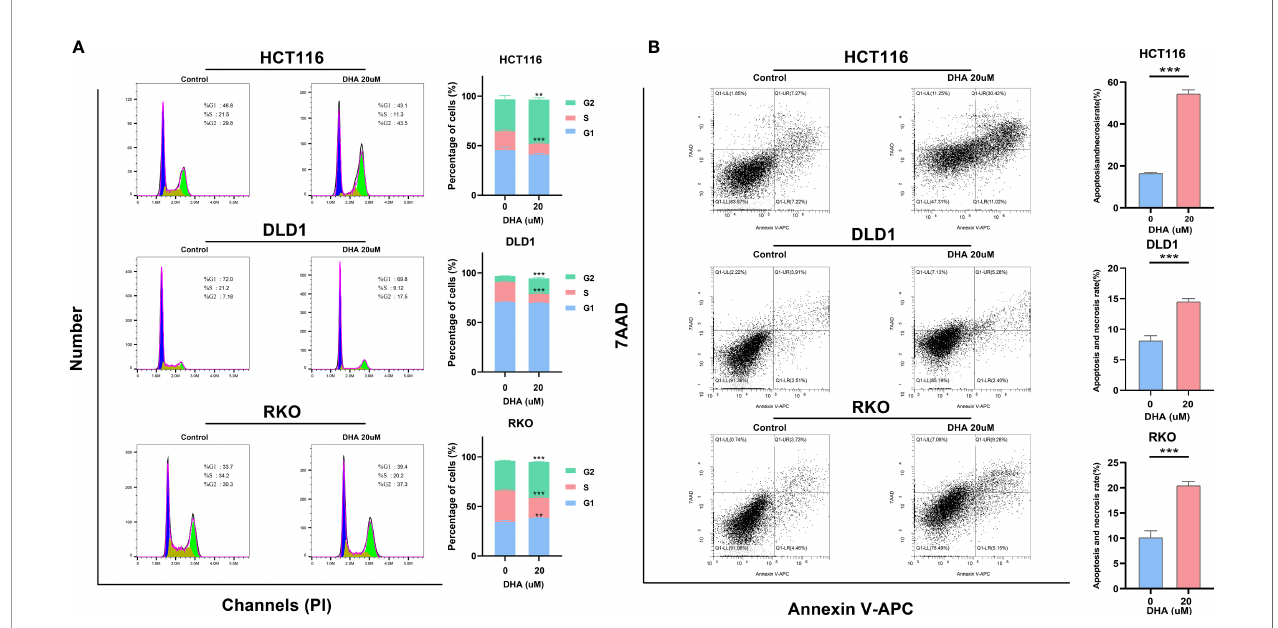
FIGURE 3 | DHA caused cell cycle arrest in the G 2 /M phase and induced cell apoptosis. (A) The effects of DHA on cell cycle distribution were examined by fl ow cytometry. (B) The effects of DHA on cell apoptosis were examined by fl ow cytometry. Data are shown as means ± SD. **p < 0.01, ***p < 0.001. DHA,